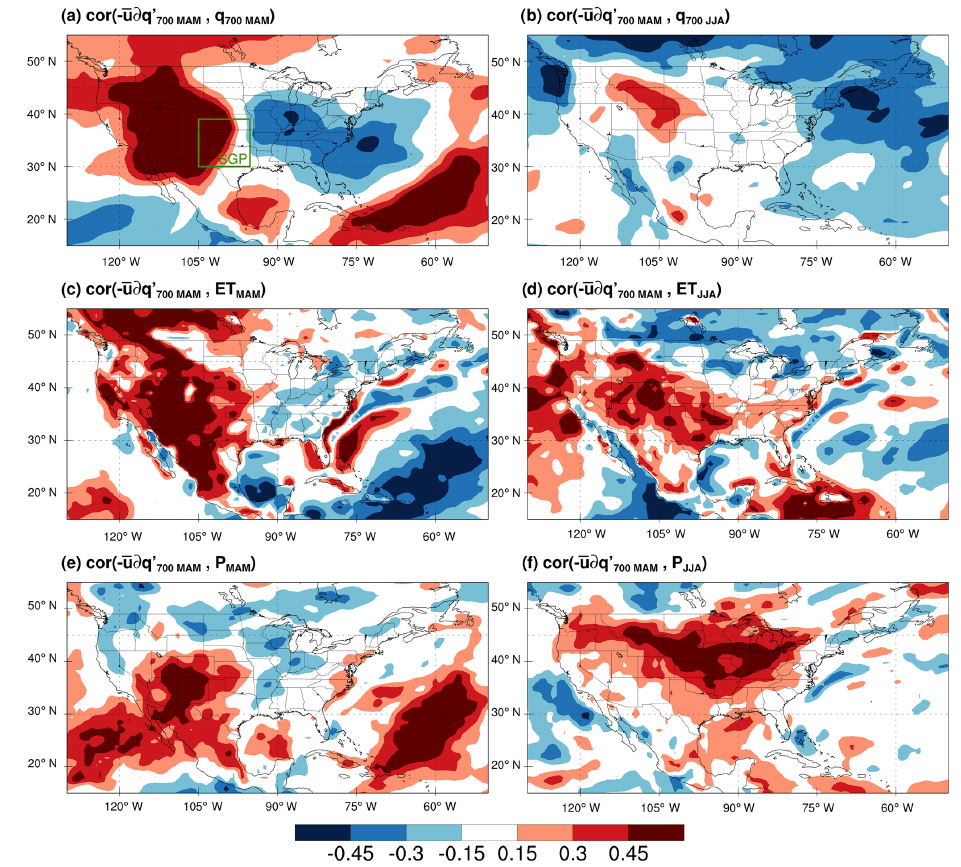
Figure 10. Single-point correlation maps between the standardized time series (1979–2018) of the MAM zonal thermodynamic advection at 700mbar averaged over the SGP (the box in a ) and the standardized anomalies of ERA-Interim specific humidity at 700mbar ( a , b ), evapotranspiration ( c , d ), and precipitation ( e , f ) for the MAM ( a , c , e ) and JJA ( b , d , f ) seasons. The correlation coefficients greater than 0.3 and 0.4 are statistically significant at the 10% and 2% levels, respectively (see Sect.